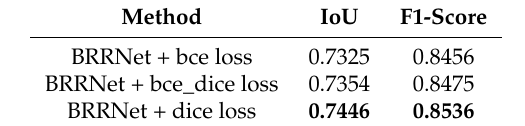
Table 2. Experimental results of different loss functions.